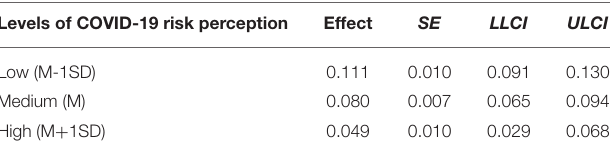
TABLE 4 | The effect of empathy on COVID-19 volunteer behavior at different levels of COVID-19 risk perception. Levels of COVID-19 risk perception